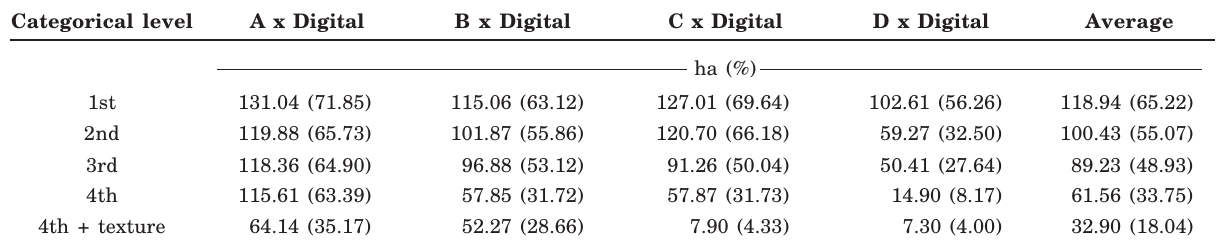
Table 4. Spatial correspondence between the digital soil map (DSM) and the conventional soil